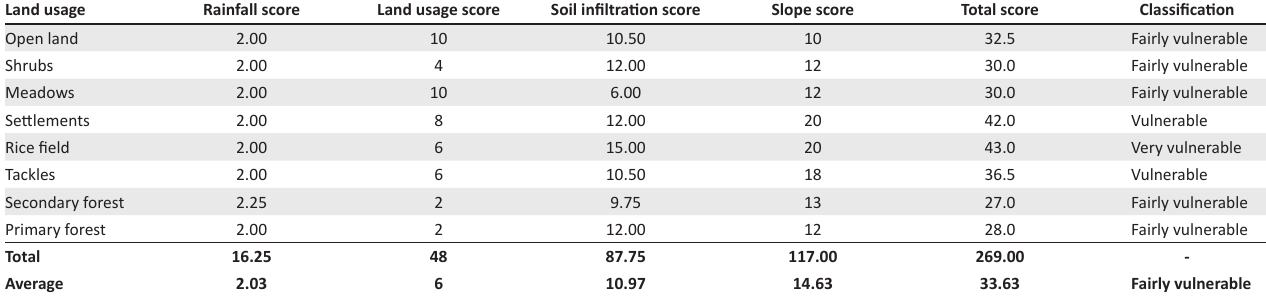
TABLE 7: Flood vulnerability levels on several land use